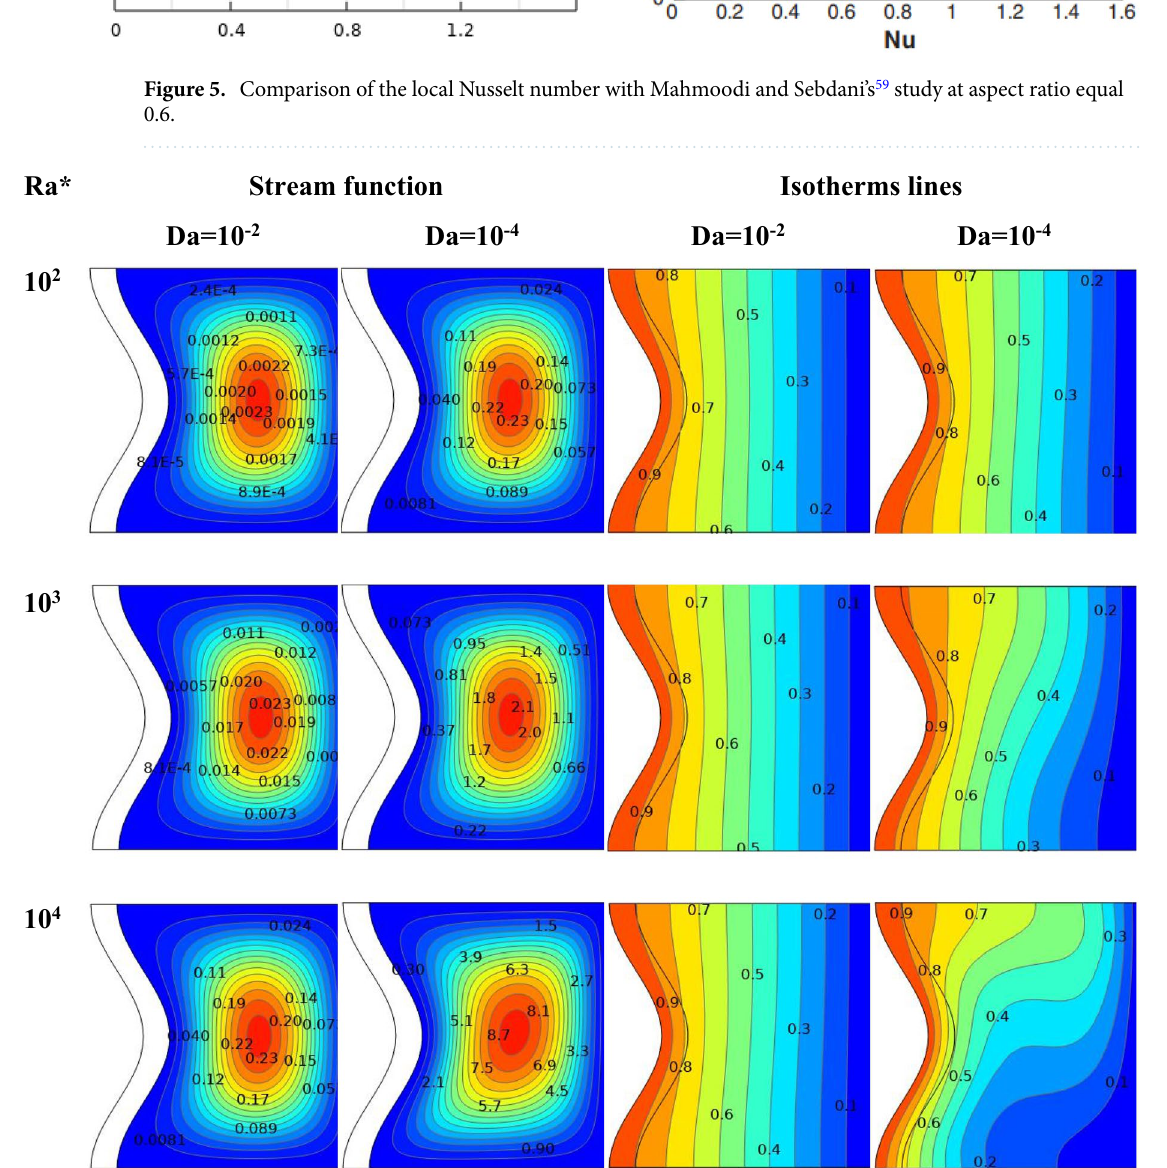
Figure 6. For different values of Da, the streamline and isotherm contours of Ra* are seen (ϕ = 0.01 ε = 0.6 kr = 1 A = D = 0.1 and N =